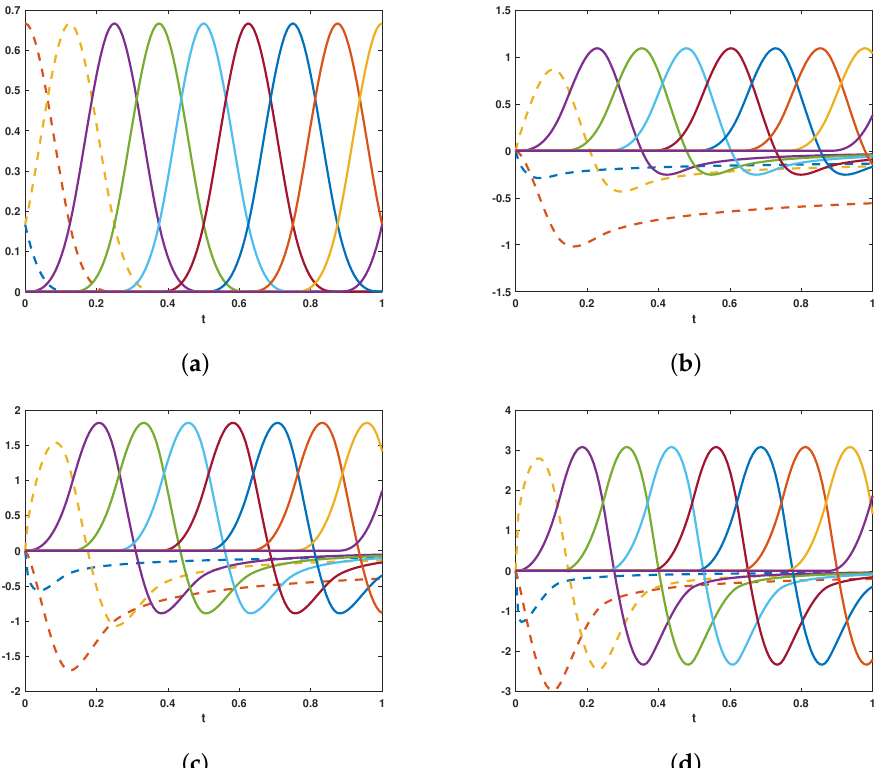
Figure 1. ( a ) The cubic basis S 3 j in the interval [ 0,1 ] at the refinement level j = 3. The left edge functions are plotted with dashed lines. ( b – d ) The fractional derivative of the cubic basis for γ = 0.25 (Panel ( b )), γ = 0.5 (Panel ( c )), and γ = 0.75 (Panel ( d